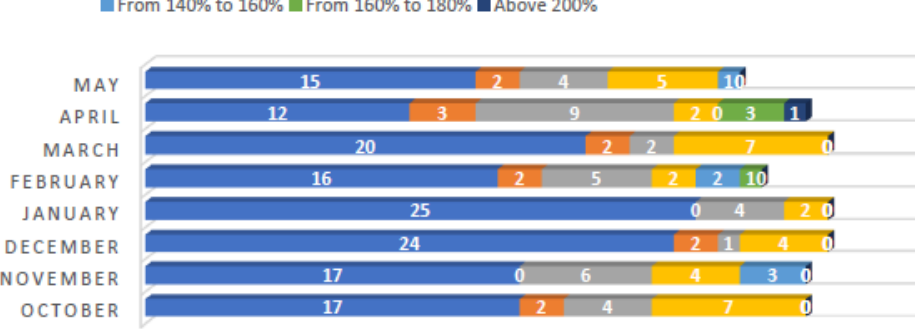
Figure 8. Daily HDD variations over specific months (indicating the number of days).